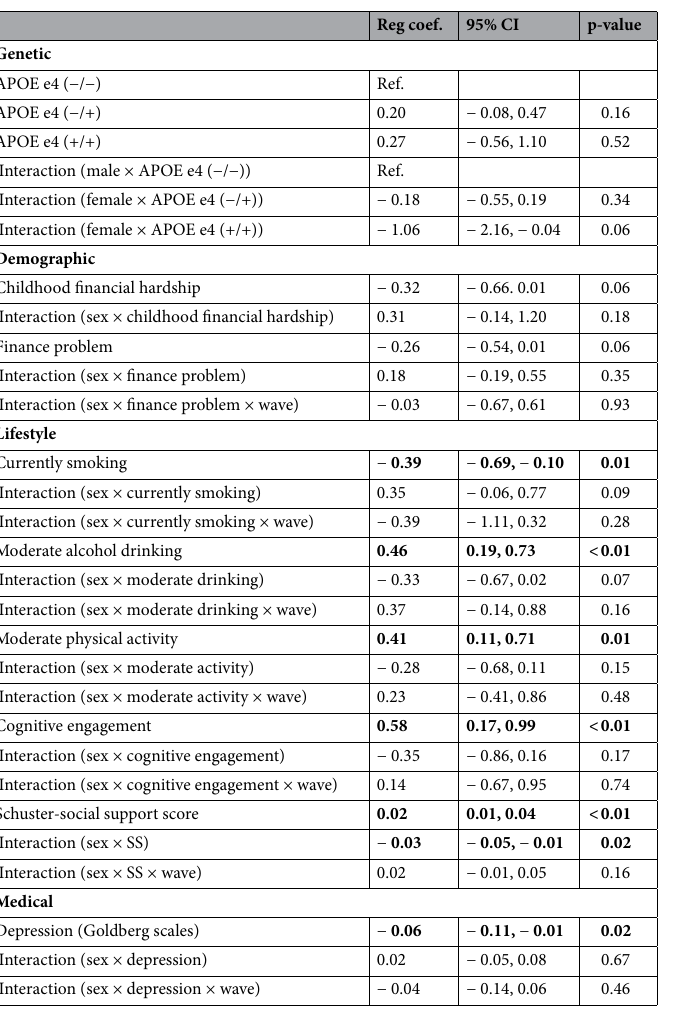
Table 1. Dementia risk factors effects on memory performance, and dementia risk factor interactions with sex, and sex and wave (40 s cohort). Bold values indicate